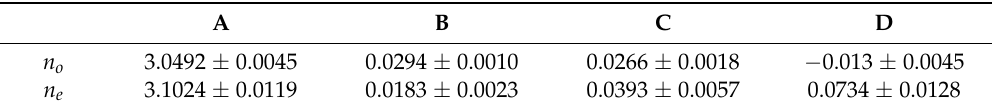
Figure 3. The measured refractive indices of Ba 2 TiSi 2 O 8 prism. Table 2. The simulated parameters of Sellmeier’s equations.